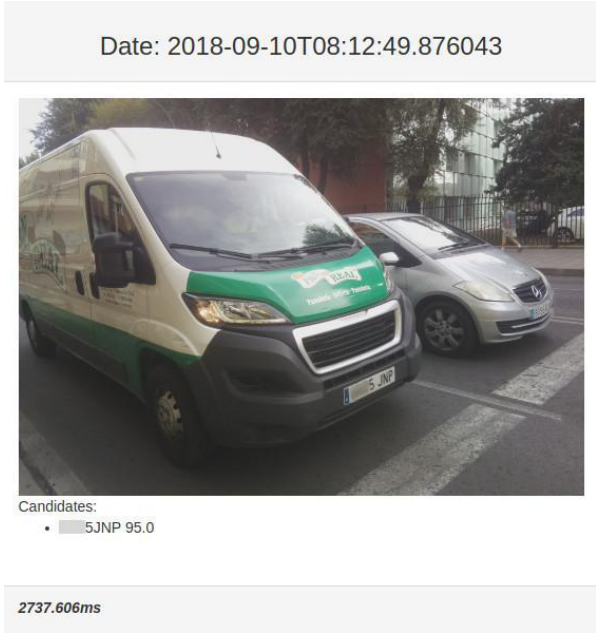
Figure 3. Visualization obtained from one of the sensors. (To protect personal data, the first three digits of the license plate have been blurred.)